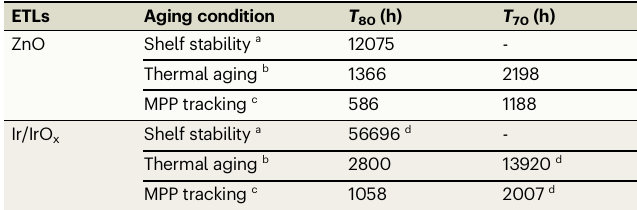
Fig. 7a, to explore the stability of OSCs under extreme temperature